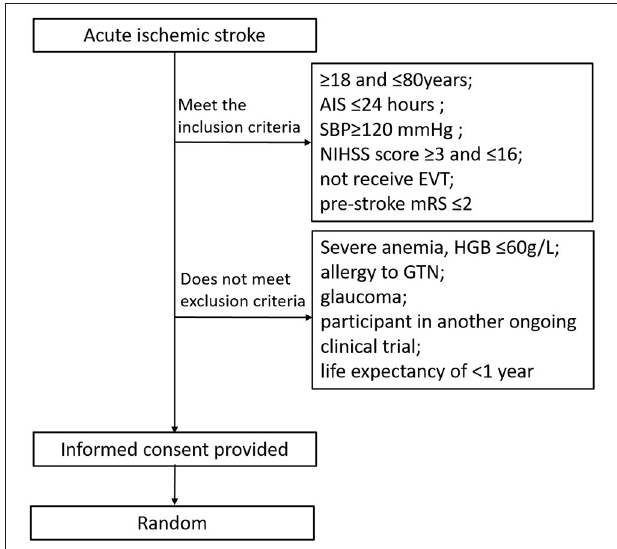
FIGURE 1 | Trial randomization flowchart. AIS, acute ischemic stroke; NIHSS, national institutes of health stroke scale; SBP, systolic blood pressure; mRS, modified rankin scale; GTN, glycerly trinitrate; HGB,